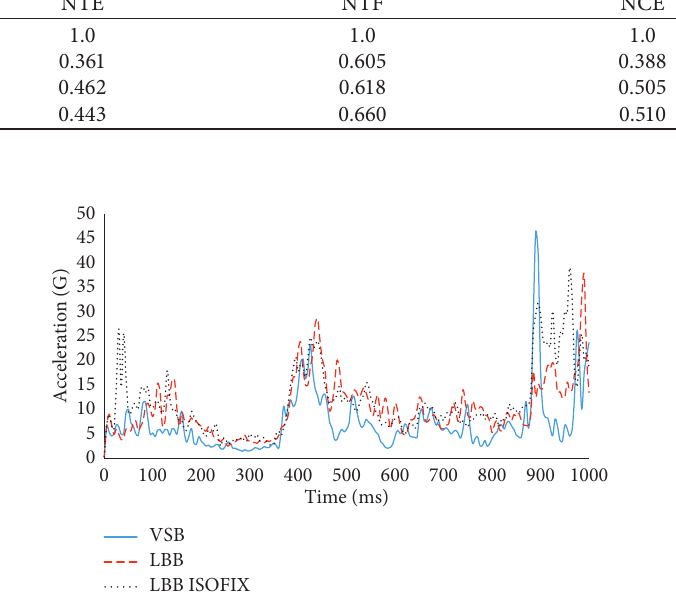
Figure 8: Thoracic spine-resultant acceleration.